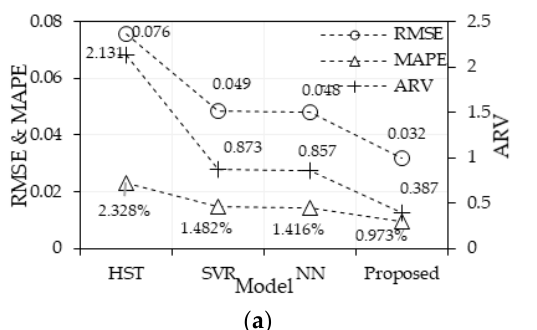
Figure 14. Performance comparison of SIE – APSO (swarm information entropy-based alienation particle swarm optimization), PSO (particle swarm optimization), LDIW – PSO (linear descent inertia weight strategy particle swarm optimization), GSA (gravitational search algorithm), and GWO (standard grey wolf optimizer). Convergence curve of each tuning algorithm. ( a ) Direction along the river, ( b ) Vertical direction.